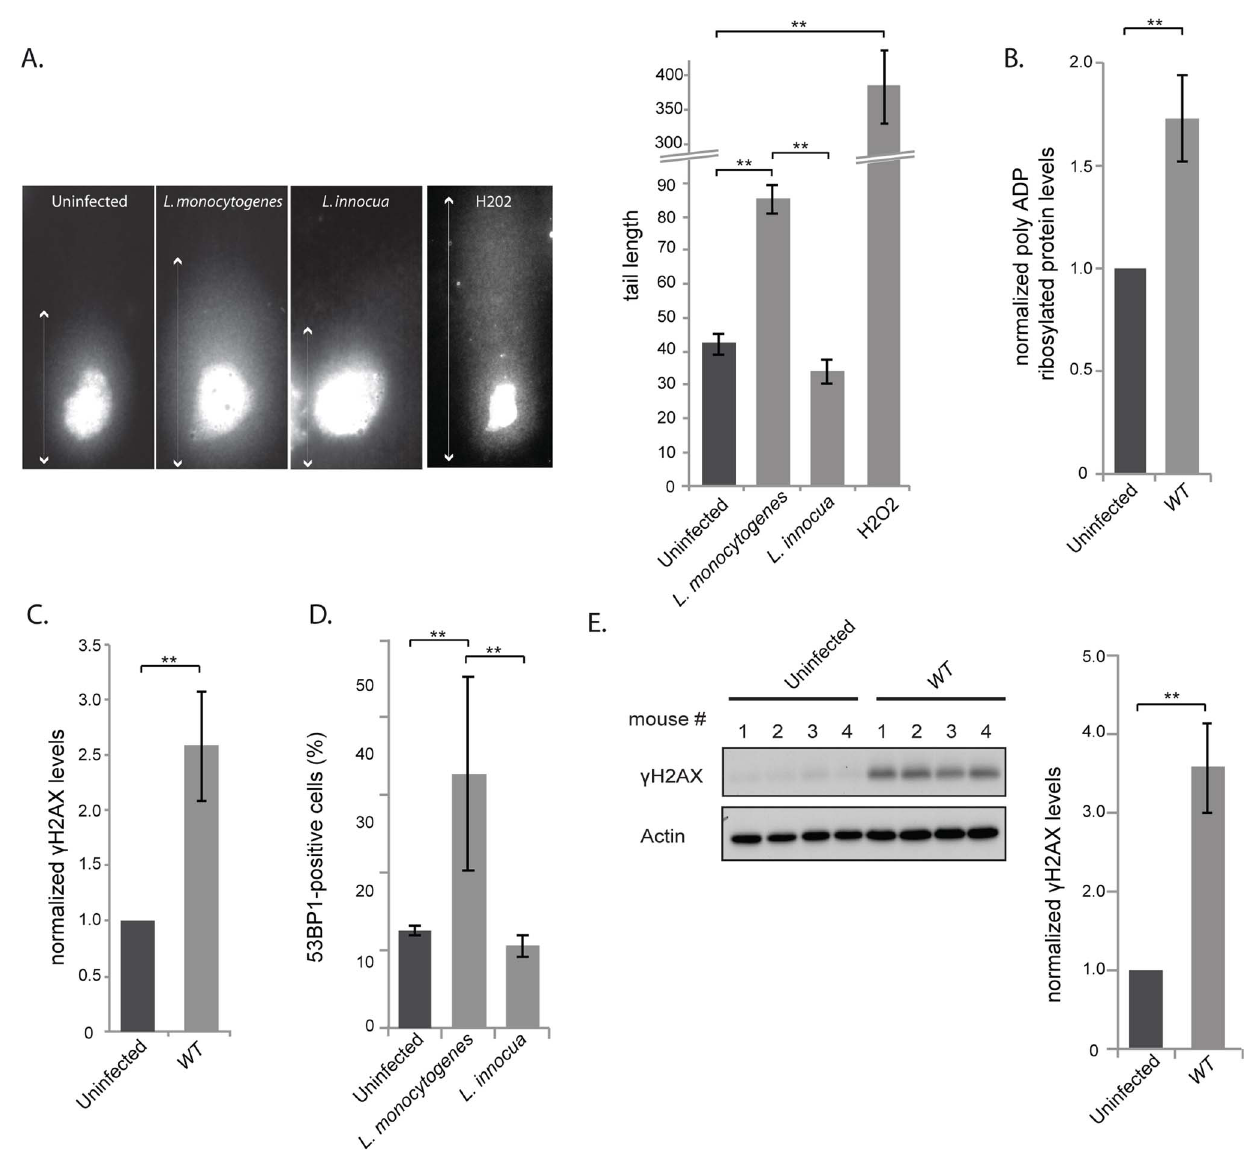
Figure 1. L.monocytogenes induces DNA breaks and mildly activates the DNA damage response. (A) Images on the left show comet assays of HeLa cell infected with the indicated strain or treated with purified listeriolysin O or hydrogen peroxide (0.5 mM), and on the right is a quantification of the images. Each box on the left measures 48,3 6 90 m m, except for the H2O2 treated condition, where the size is double. The white arrows indicate the measured tail length which is recorded and averaged in the histogram on the right. Each bar in the histogram is an average of at least 30 nuclei from at least 3 independent experiments. (B) and (C) HeLa cells were infected with L. monocytogenes EGD for 24 h. Cell extracts were collected for immunoblot analysis. The polyADP and c H2AX levels are normalized to actin and to the uninfected condition (n $ 3). (D) HeLa cells were infected with Listeria for 24 h. 53BP1 foci were visualized by immunofluorescence and quantitated over at least 3 experiments, for a total of more than 500 cells counted. (E) Immunoblot images are shown on the left and quantifications on the right. The left image is shown for 1 experiment on spleen homogenates from C57Bl/6J mice infected with L. monocytogenes EGD for 72 h. The histogram on the right integrates 2 experiments ( n =8 animals per condition). All quantifications in graphs show the mean + / 2 SEM (** indicates p , 0.01). treated cells with the actin polymerization inhibitor cytochalasin D to block bacterial entry and measured the size of the cellular comets observed. These results also show that bacterial internal- ization was not necessary for inducing host cell DNA damage (figure S3A). Consistent with these results, extracellular Listeria (either infection with the D inlB mutant or pretreatment of cells with cytochalasin D prior to infection with wild type bacteria) showed the same level of c H2AX as observed upon infection with Listeria able to invade host cells (figure 2 and S3B).